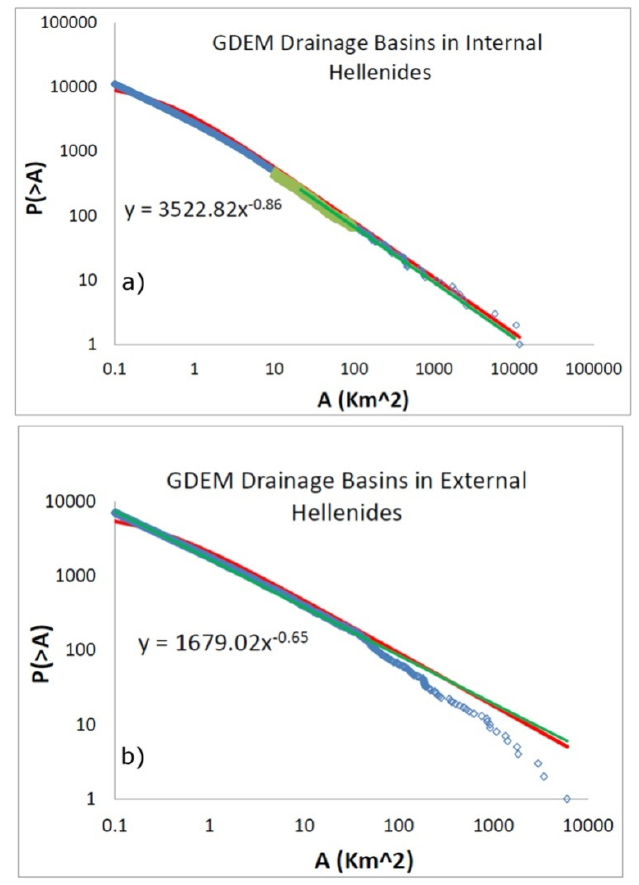
Figure 6. The drainage distribution for Internal ( a ) and External ( b ) Hellenides, Greece. A power law fitting is presented with β int ≈ 0.86, and β ext ≈ 0.65 for the internal and external Hellenides, respectively (green line) along with the Q-exponential (red line) with Q int ≈ 2.16 and Q ext ≈ 2.45 for the internal and external Hellenides, respectively (see text).